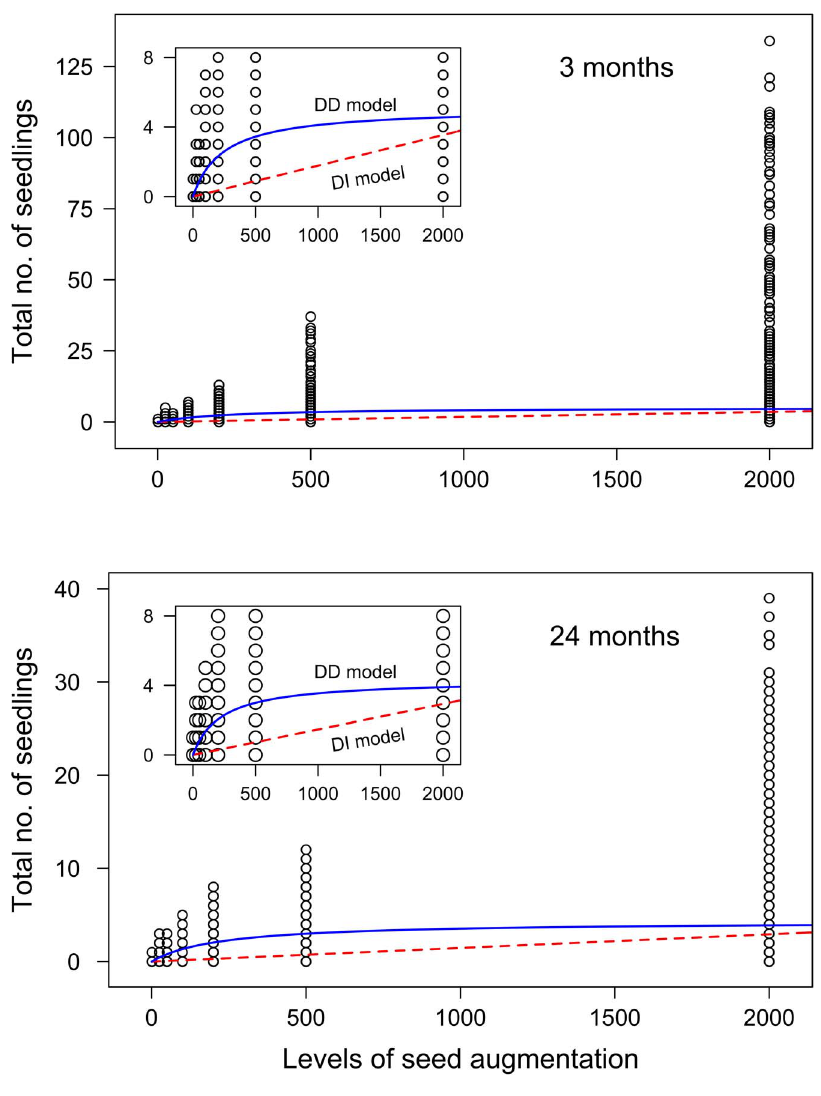
Figure 2. Fit of the two recruitment functions to seed augmentation data. Data are the number of seedlings in each quadrat of all five species at (A) three and (B) 24 months after sowing. The inset graphs emphasize the differences between recruitment functions by magnifying the image (note the truncated y-axis). The dashed line represents the density-independent (DI) model (fitting P 0 and S amb ). The solid line represents the density-dependent (DD) model, accounting for seed-limitation, density-independent limitation, and density-dependent limitation (fitting P 0 , S amb , and R max ). The level of seed augmentation is a multiple of ambient densities observed in nature for each species during the first year of this project. For all species, the density-dependent model provided a better fit than the linear model (see Table S1), providing evidence of density-dependence.